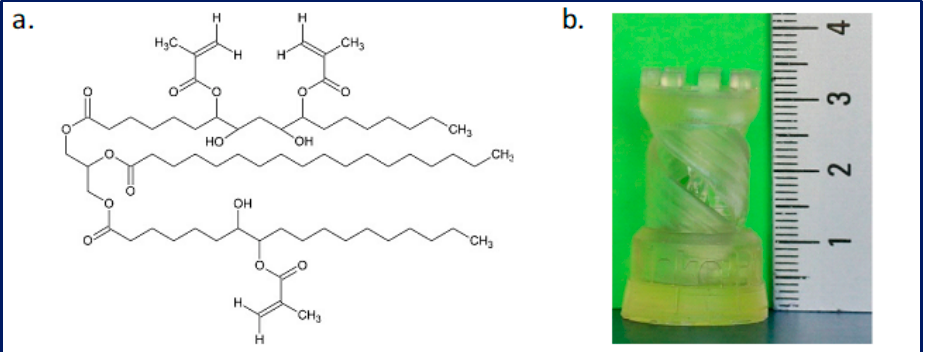
Figure 3. ( a ) Photocurable resin based on soybean oil for stereolithographic 3D printing and ( b ) picture of rook tower prototype printed with ESOMA 3 . Reprinted with permission from [71] .